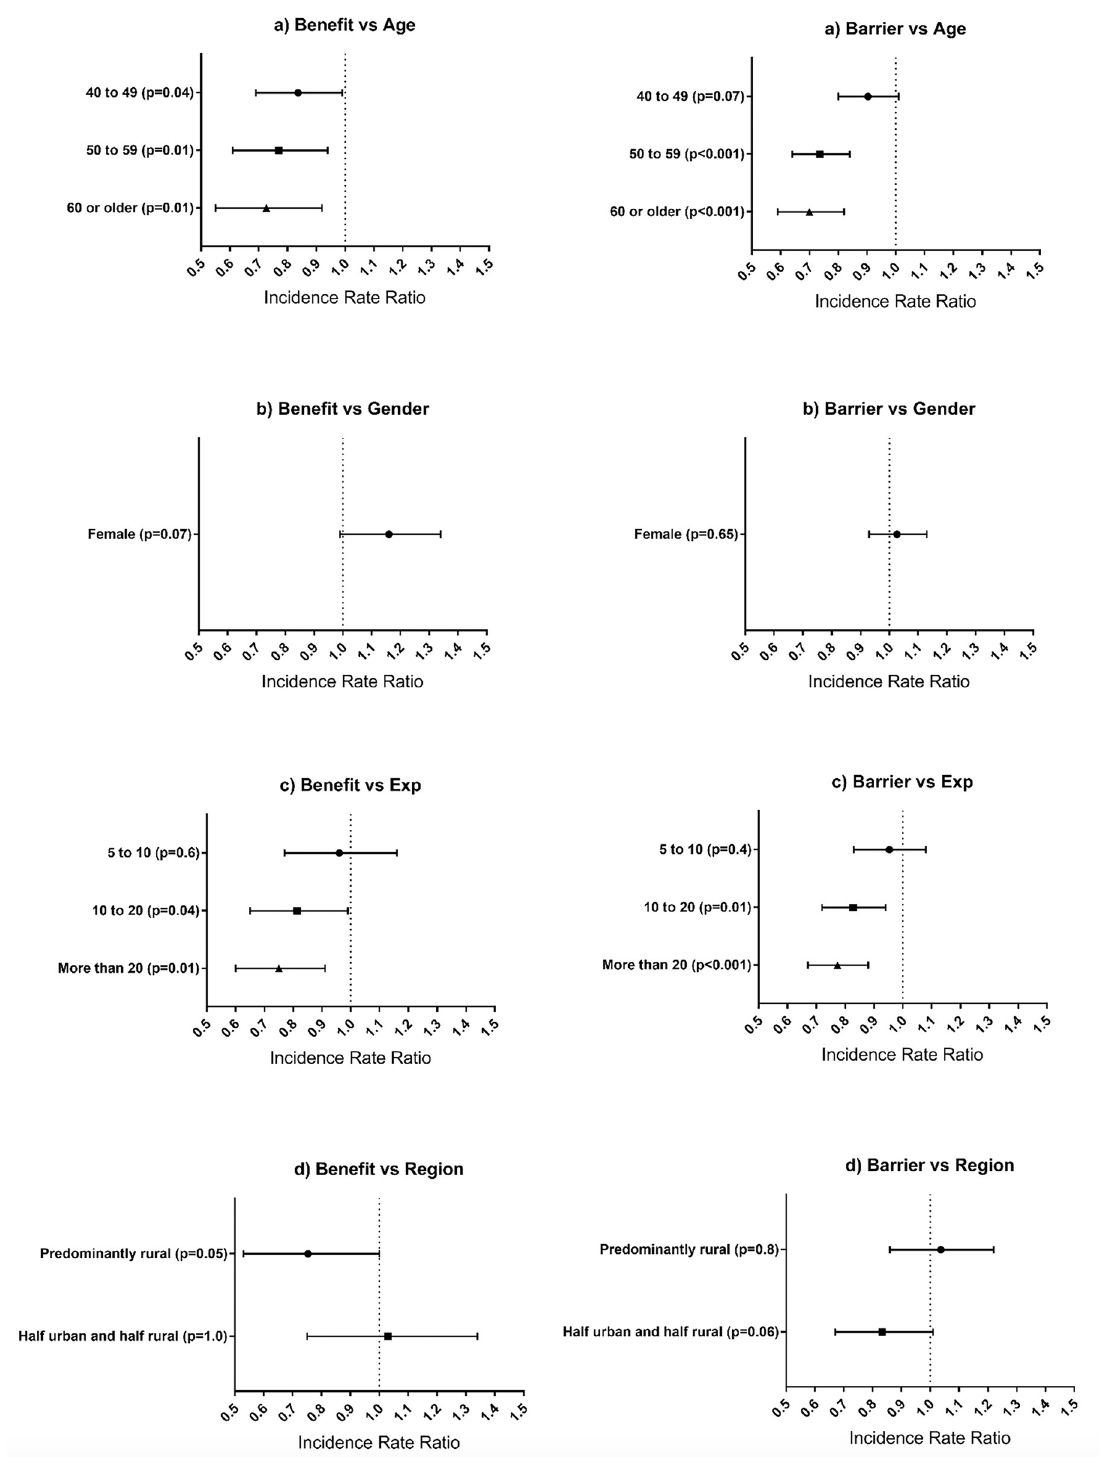
Fig 1. Relationship between demographic factors and number of benefits of and barriers to attending their patient’s funeral. The vertical, dotted line represents the reference group and refers to the following: a) Age: 30–39, b) Male, c) Experience: Less than 5 years, d) Practice: Predominantly urban. The incidence rate ratio represents a factor change in the expected number of benefits and barriers chosen by participants compared to the reference category.